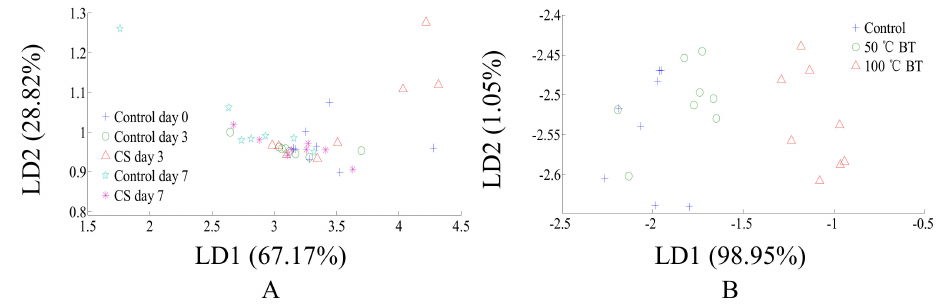
Figure 3. LDA classification for different postharvest handling treatments of tomatoes based on physicochemical parameters. ( A ) cold storage, ( B ) blanching